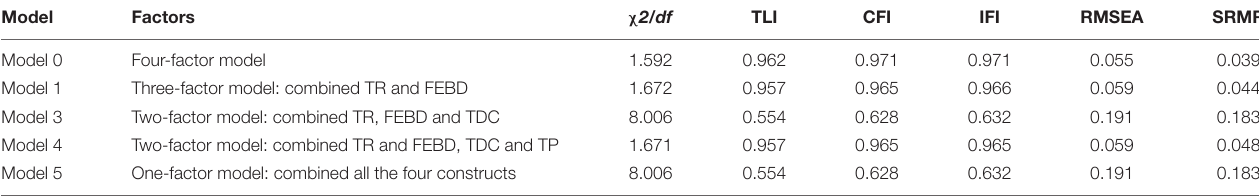
TABLE 1 | Confirmatory factor analysis for discriminant validity.